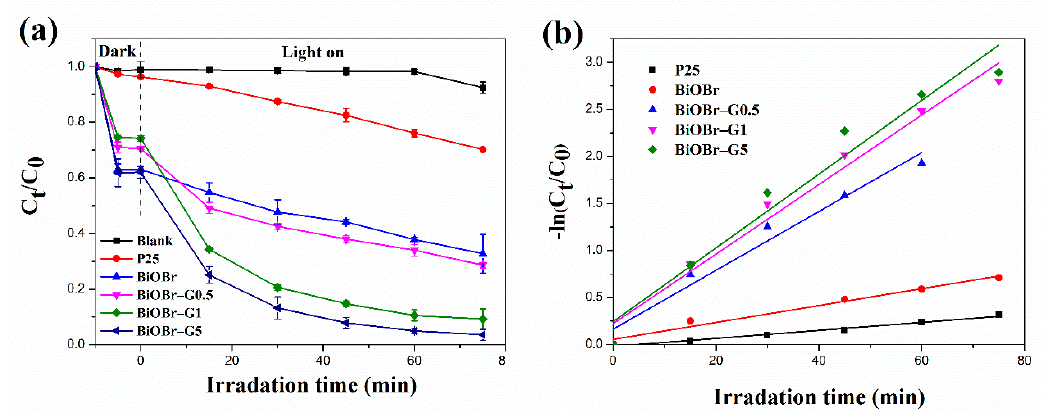
Figure 8. ( a ) Photocatalytic degradation of MB by P25, BiOBr, and BiOBr-Gs. ( b ) Photocatalytic kinetic of P25, BiOBr, and BiOBr-Gs. 404 Table 1. MB removal rate and kinetic constant of various catalysts reported in previous studies. 405